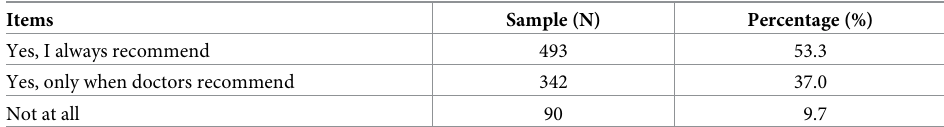
Table 9. Do you personally recommend use of dietary supplements to others.